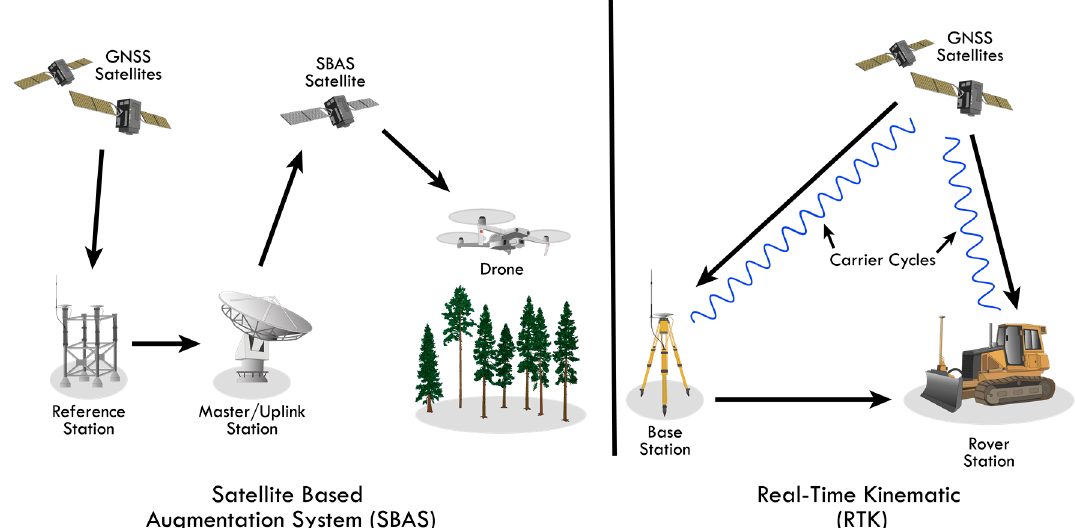
Figure 3. In a Satellite-Based Augmentation System (SBAS) ( left panel), reference stations located at precisely-surveyed points receive and forward their GNSS signals to the master station, which then calculates corrections. These corrections are sent to SBAS satellites, which in turn broadcast correction messages to the end user. In a Ground-Based Augmentation System (GBAS), such as real-time kinematic (RTK) positioning ( right panel), a base (reference) station at a known location and a mobile rover both receive pseudorange and carrier phase measurements from similar satellites. Common errors between the units are estimated and correction data from the base station is transmitted to the rover for use in real-time or is utilized in post processing.